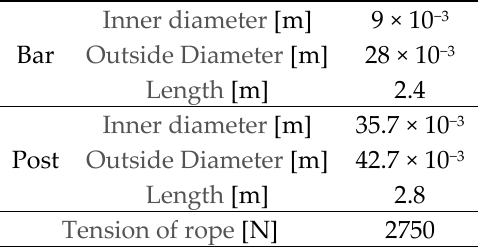
Table 1. Specification of the horizontal bar.